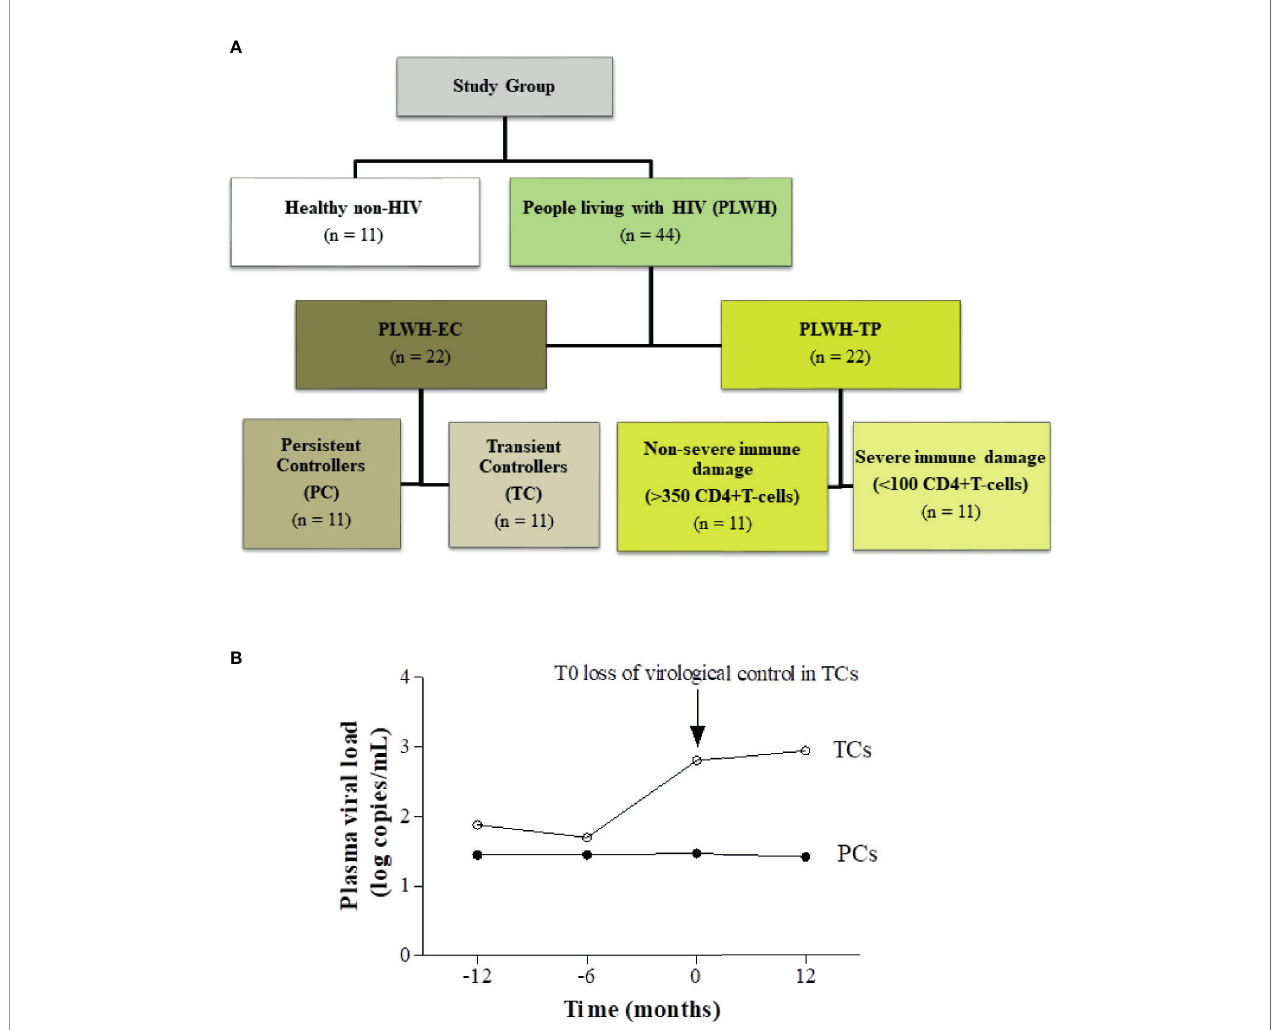
FIGURE 1 | Study design. (A) Flow chart illustrating subject cohort enrolment and analysis. People living with HIV (PLWH), grouped into elite controllers (PLWH-EC) and typical progressors (PLWH-TP), were compared to a group of healthy non-HIV subjects. The PLWH-EC group was grouped according to their virological progression as persistent controllers (PCs) if they maintained virological control over time or as transient controllers (TCs) when they lost the spontaneous viral load during at least two consecutive measurements during one year. The PLWH-TP group was also categorized according to their pre-cART CD4 + T-cell counts in subjects presenting nonsevere immune damage (>350 CD4 + T-cells) or subjects with severe immune damage (<100 CD4 + T-cells). (B) Schematic representation indicating the follow-up time point of the study design in PLWH-EC. The arrow indicates T0, the time point closest the time when TCs lost the virological control, which was considered the